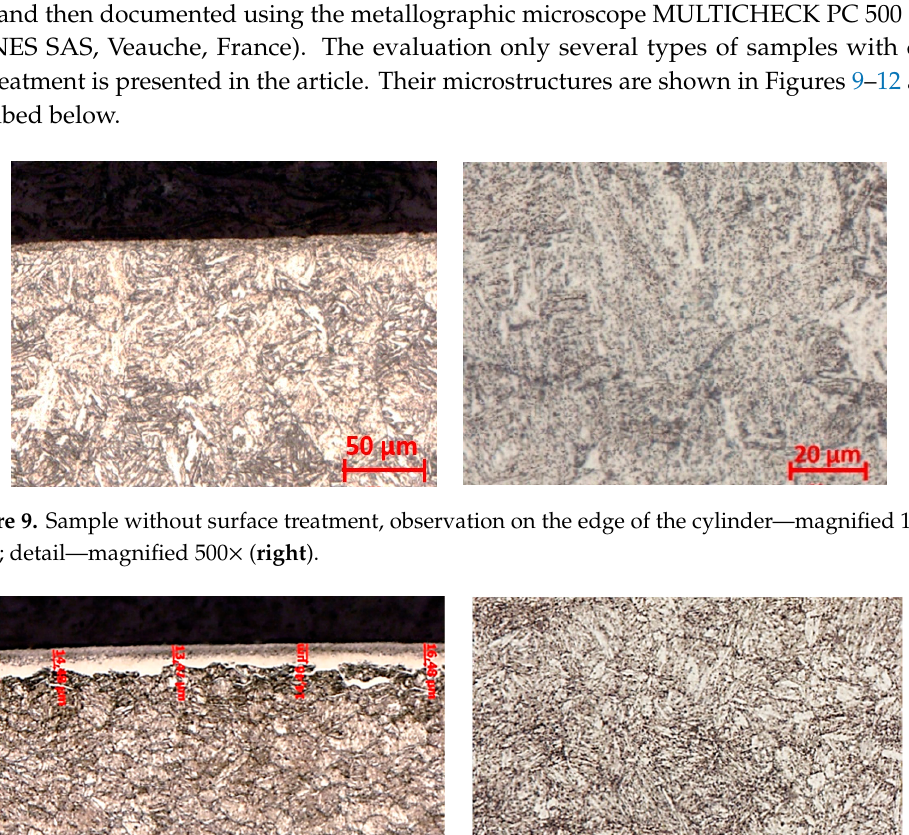
Figure 10. Nitrided sample—white layer thickness magnified 200 × ( left ); sample centre magnified 500 × ( right ).